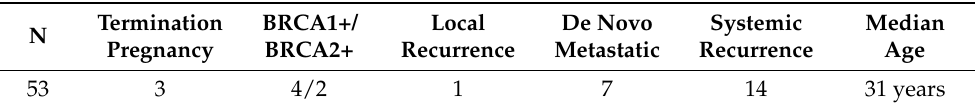
Table 5. Patients with breast cancer occurring during pregnancy (BCP) were treated at the Department of Oncology of the First Faculty of Medicine and the General Hospital in Prague